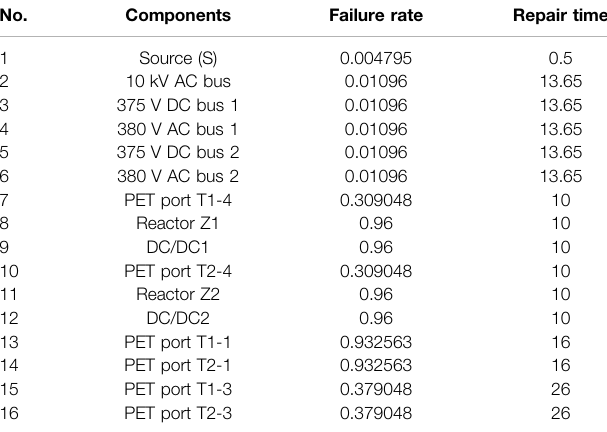
TABLE 4 | Calculation results of reliability indexes with different port capacities.